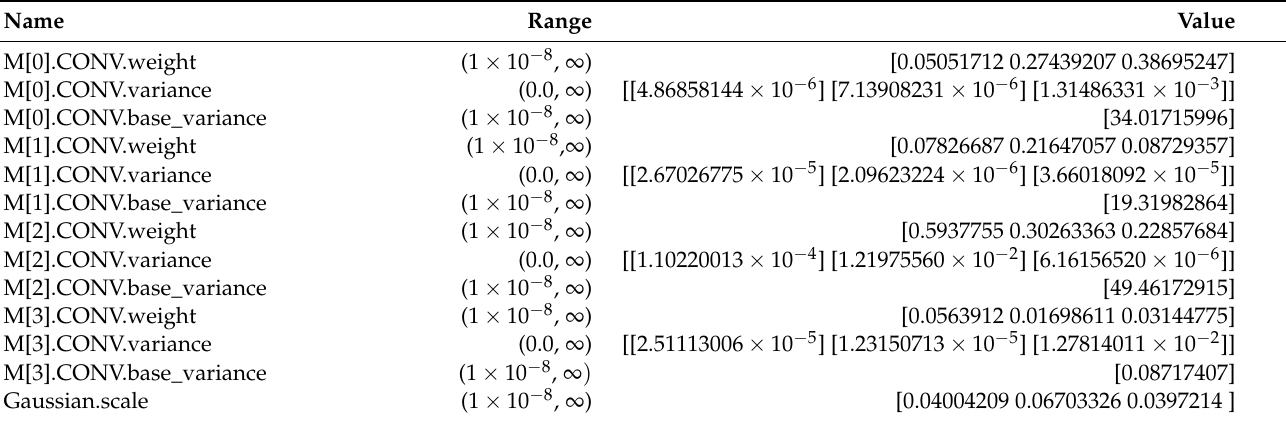
Table A4. Hyperparameters of the MOGP model trained with the S2 GP VWC and S1 RVI orbits 68 and 141 time series over the winter wheat 2021